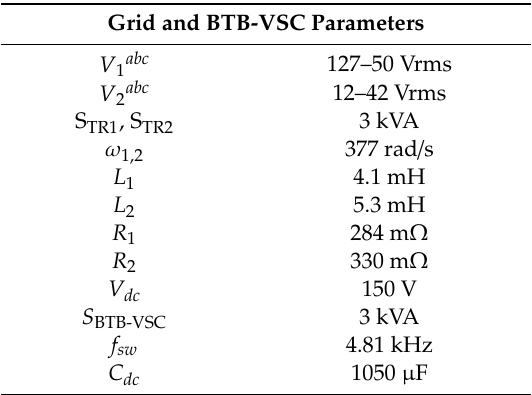
Table 5. Prototype parameters for